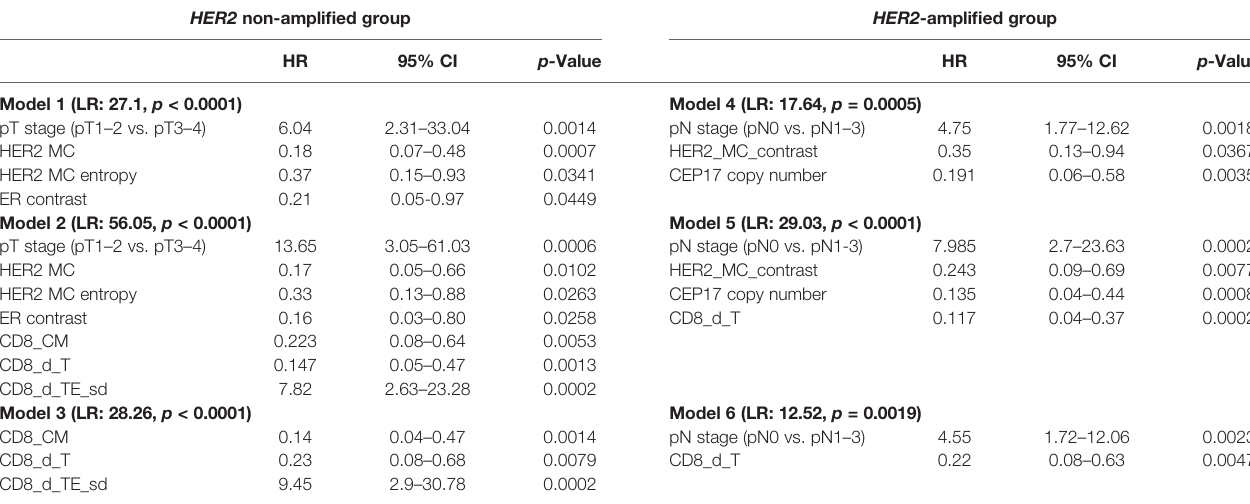
TABLE 3 | Multivariate analysis of prognostic factors associated with OS in HER2 non-ampli fi ed (models 1, 2, and 3) and HER2 -ampli fi ed (models 4, 5, and 6) patient groups. HER2 non-ampli fi ed